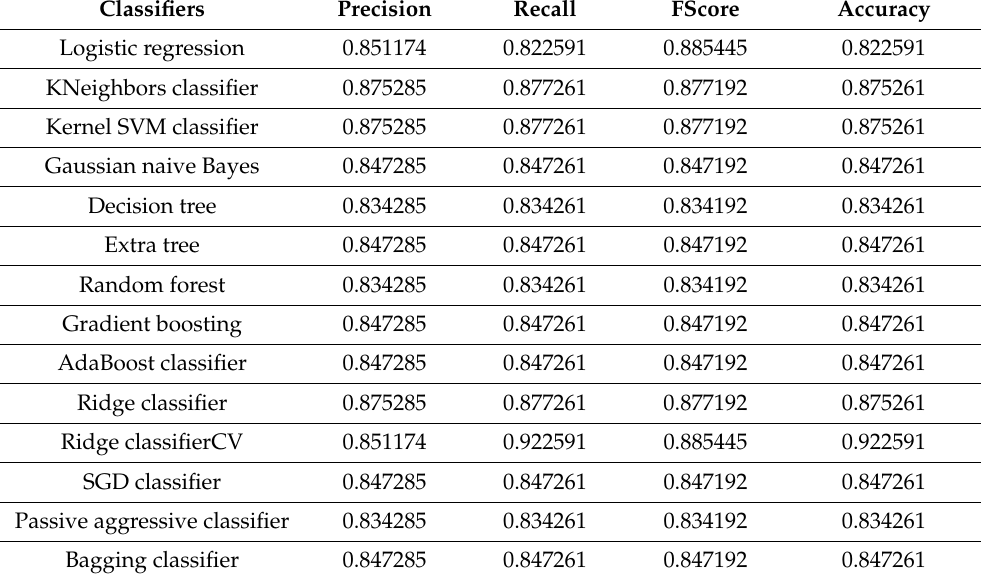
Table 19. Gradient boosting classifier metrics before feature scaling.